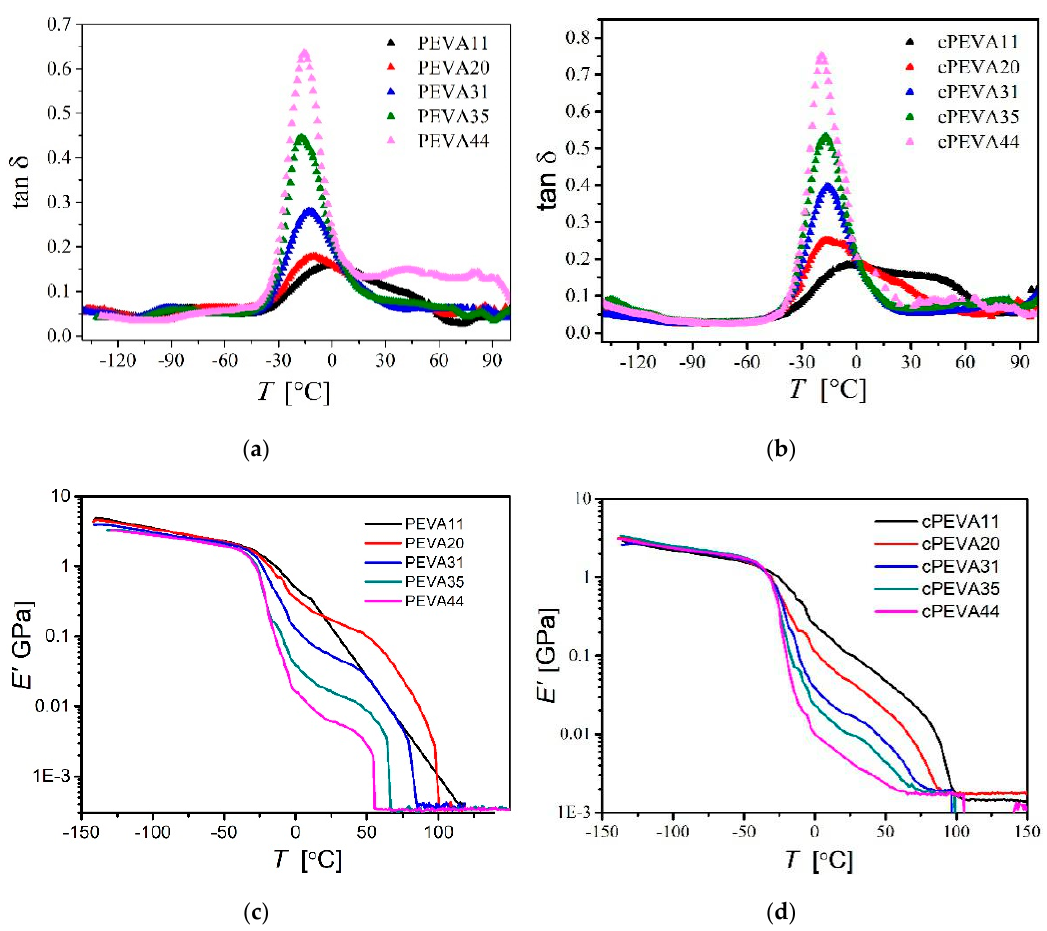
Figure 7. Dynamic mechanical analysis (DMA) at varied temperatures: ( a ) tan δ ‐ temperature curves of PEVAs with different VA ‐ contents. Two relaxation glass transition processes were observed for PE domains and copolymer chain. ( b ) tan δ ‐ temperature curves of cPEVAs, where only one relaxation progress was observed as glass transition step of copolymer chain. ( c ) Storage modulus ( E ′ ) ‐ temperature curves of PEVAs. ( d ) Storage modulus ( E ′ ) ‐ temperature curves of cPEVAs.